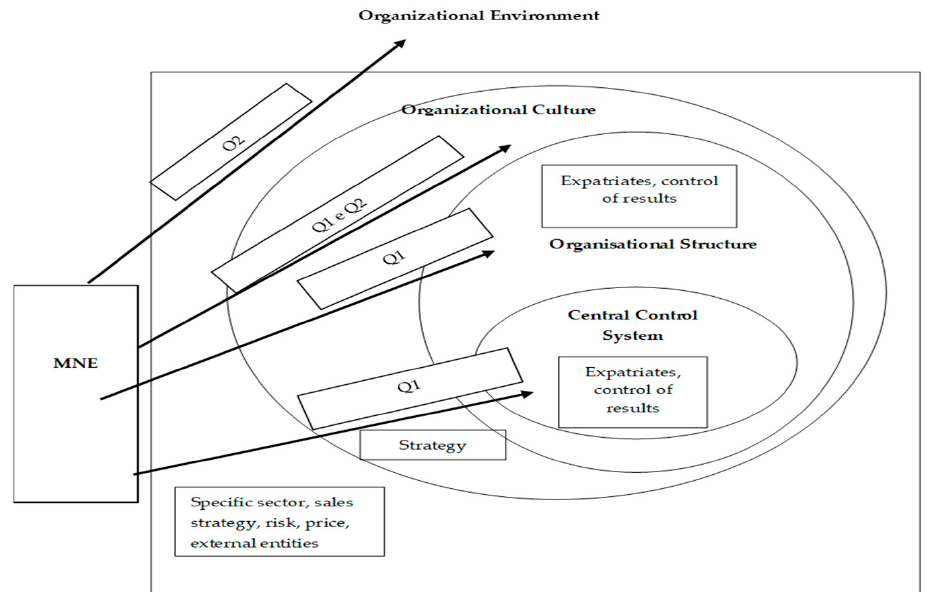
Figure 1. Flamholtz analysis model (1996) (Influence of the parent company on the subsidiary), adapted from Flamholtz